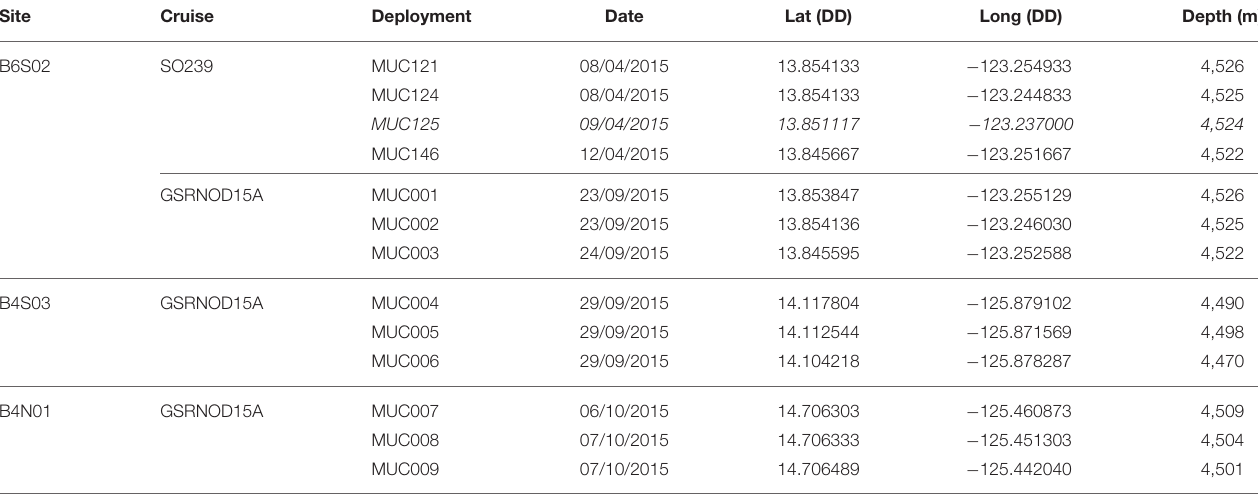
TABLE 1 | Details of the multicorer (MUC) deployments during sampling cruises GSRNOD15A (October 2015) and SO239 (April 2015). Site Cruise